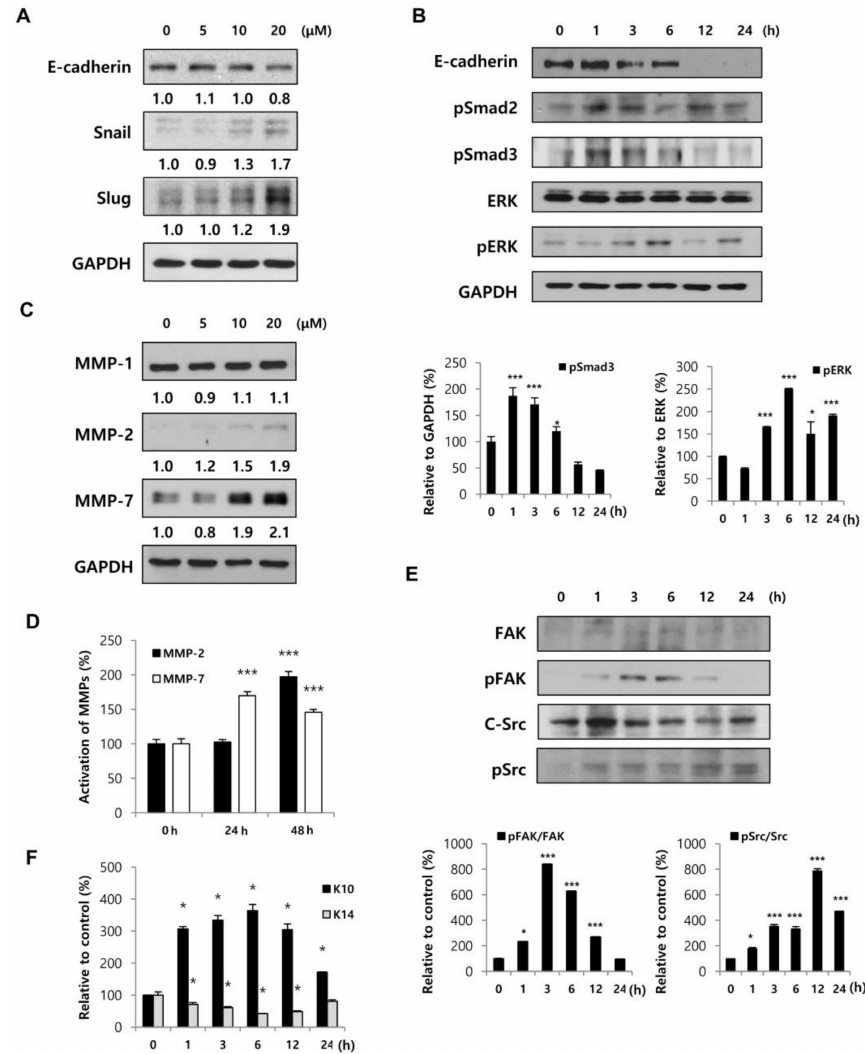
Figure 3. BMM promotes HaCaT cell migration by inducing an EMT-like phenotype and FAK/Src pathway and stimulates differentiation. ( A ) HaCaT cells (1 × 10 5 each) were seeded on 100 mm cell culture dishes and incubated for 24 h; Protein lysates from cells treated with BMM in a dose-dependent and ( B ) time-dependent manner were collected using RIPA solution, and proteins were resolved by 10% sodium dodecyl sulfate-polyacrylamide gel electrophoresis (SDS-PAGE). Western blot to detect the expression of EMT-related factors was performed, and expression levels were normalized to GAPDH. The values indicate intensities of protein expression with respect to that of the loading control; ( C ) Western blotting for HaCaT cells treated with BMM for 24 h and MMP expression was measured. The expression levels were normalized to GAPDH. The values indicate intensities of protein expression with respect to that of the loading control; ( D ) Western blotting for secretion of MMPs from BMM-treated-HaCaT cells. Conditioned medium was concentrated using an Amicon centrifugal filter and total protein concentration was measured by the Bradford assay. The graph indicates expression levels normalized to PonceauS, as a loading control; ( E ) Western blot to measure the expression of phospho-FAK and phospho-Src as a mechanism of migration in BMM-treated HaCaT cells. The activation of the FAK/Src pathway was calculated by comparing with total-FAK and total-Src; ( F ) Western blot assay to detect differentiation and proliferation of HaCaT cells, which are respectively marked with K10 and K14, after BMM treatment, and in all cases, expression levels were normalized to GAPDH. * p < 0.05 and *** p < 0.001 as compared to the